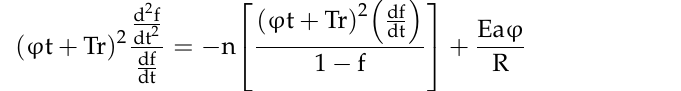
Experimental conversion values were first fitted (α and β are adjustable parameters) to a sigmoidal function (Equation (2)) to analytically calculate the first- (df/dt) and second- order time derivatives (d 2 f/dt 2 ). In Equation (2), parameters α and β were estimated based on a simplex algorithm applied to a least-squares function of the differences between experimental and calculated conversion values.